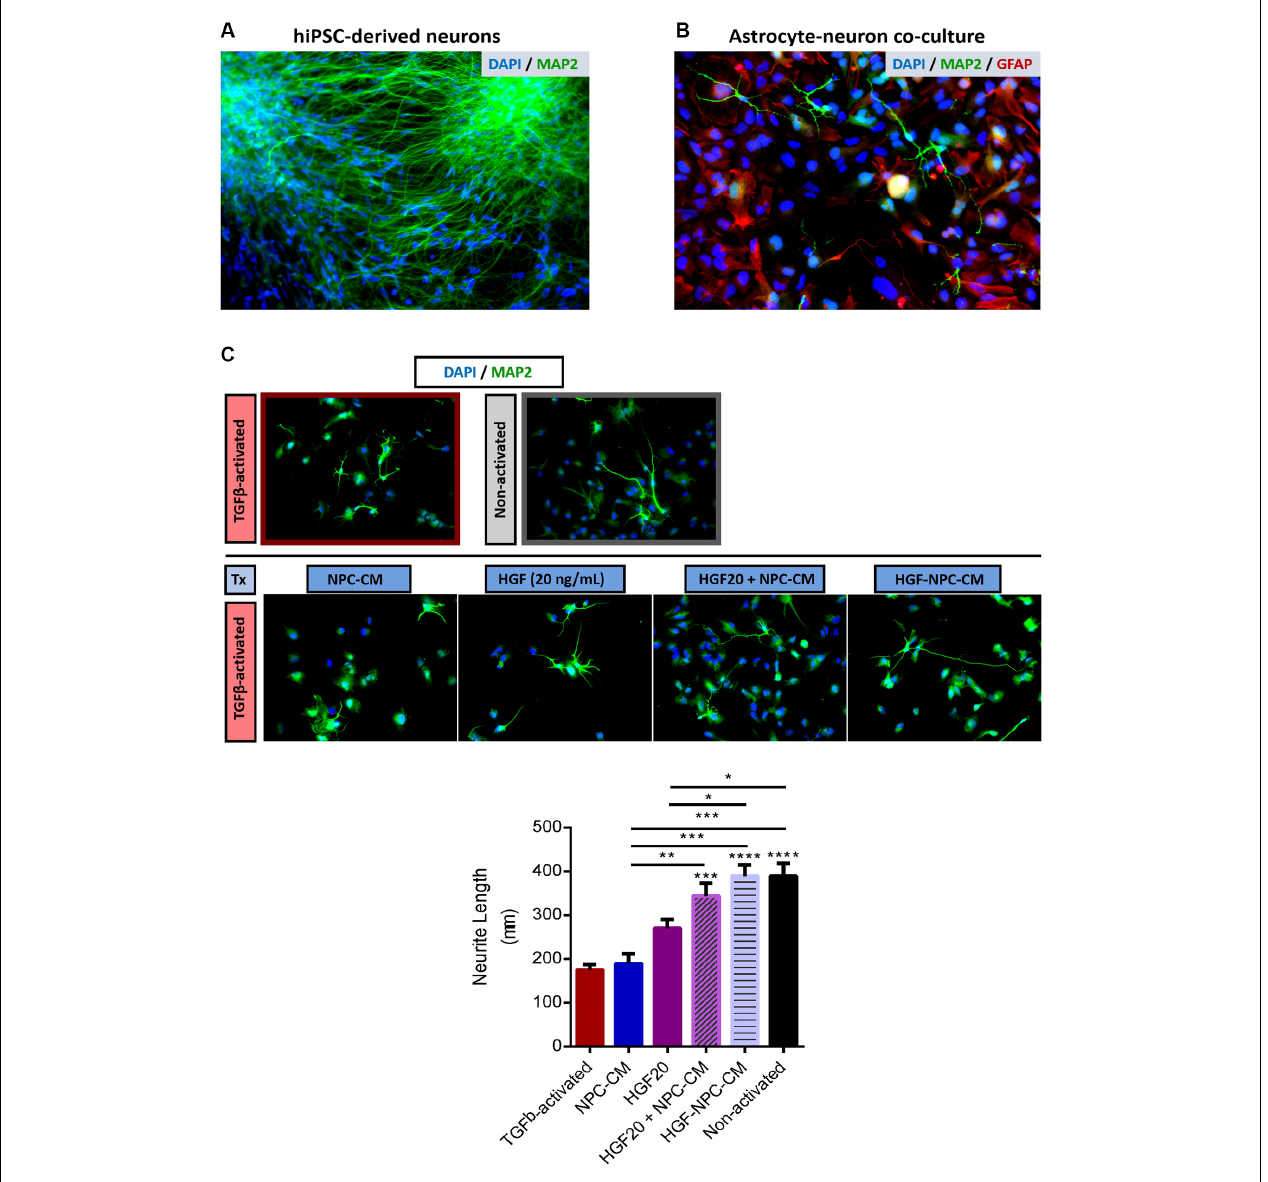
FIGURE 4 | Combinatorial treatment with HGF-enhanced NPC-CM demonstrates increased neurite outgrowth of hiPSC-neurons in reactive astrocyte co-culture. (A) Immunostaining of hiPSC-derived neurons with neuronal and dendritic marker MAP2 (green) and DAPI (blue). Representative image taken at 20 × . (B) hiPSC-derived neurons were plated onto a confluent monolayer of TGF β -activated astrocytes. Immunostaining of neuronal and dendritic marker MAP2 (green), astrocyte reactivity marker GFAP (red), and DAPI (blue). (C) Treatments were applied to reactive astrocyte-neuron co-culture for a span of 4 days and imaged at 20 × thereafter. There was approximately a 50% decrease in the total neurite length of neurons plated atop reactive astrocyte substrates relative to non-activated astrocytes. Combinatorial treatment applied to reactive-neuron co-cultures demonstrated a significant increase in neurite length compared to reactive astrocyte controls; the extent of this growth was comparable to that of the non-activated astrocyte substrate. Combinatorial treatment also proved more effective than either HGF or NPC-CM alone. Data are expressed as mean ± SEM; one-way ANOVA statistical analysis with Tukey’s post hoc test; * p ≤ 0.05, ** p ≤ 0.01, *** p ≤ 0.001, **** p ≤